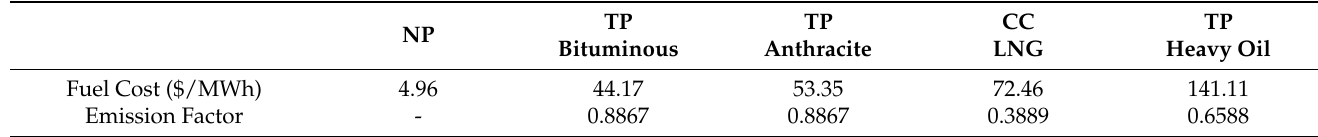
Table 2. Average fuel cost and CO 2 emission factor by fuel